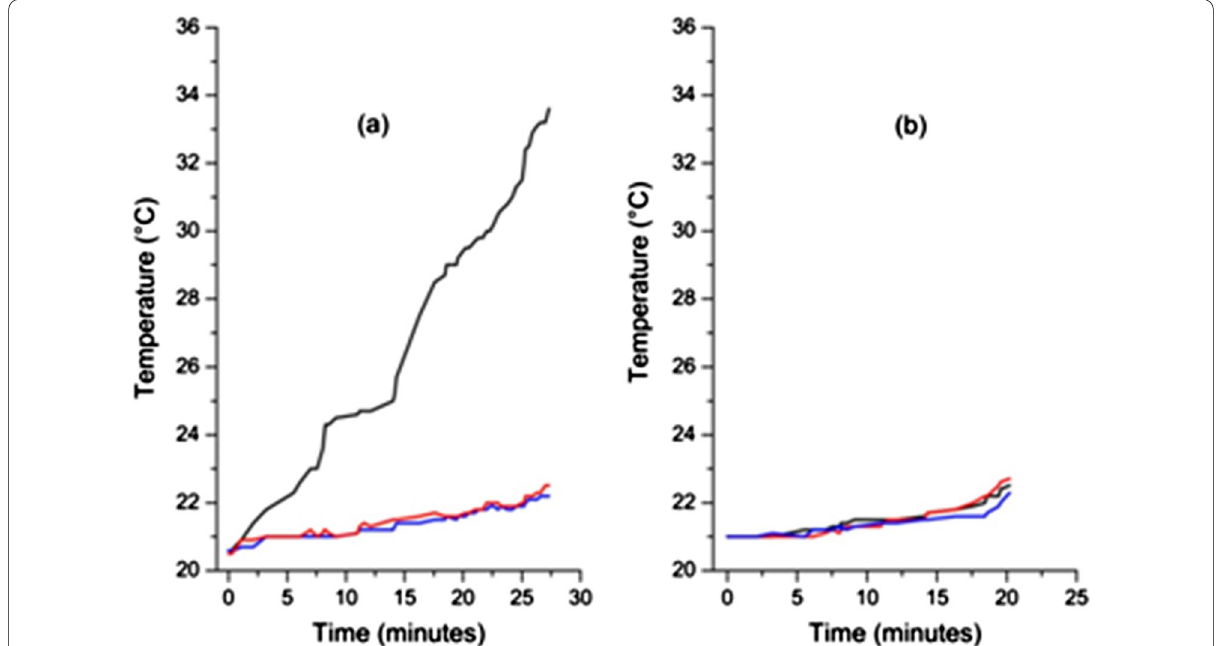
Fig. 5 Temperature over time trend of body and head coil of the 1.5 T MRI equipment. a Black line represents the hot spot temperature trend, red and blue lines are related to ROIs centered on the coil amplifier and on the right area of the coil image, respectively. b Temperature trend of the ROIs depicted on the head coil